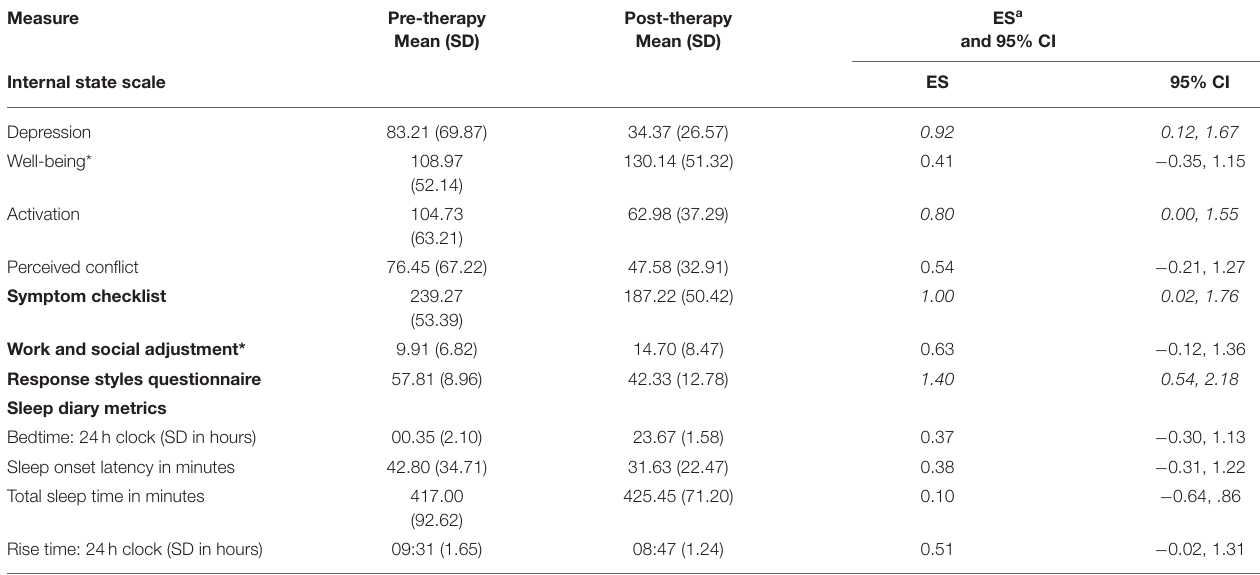
TABLE 2 | Scores pre- and post-CBT-R for 14 participants who commenced therapy.